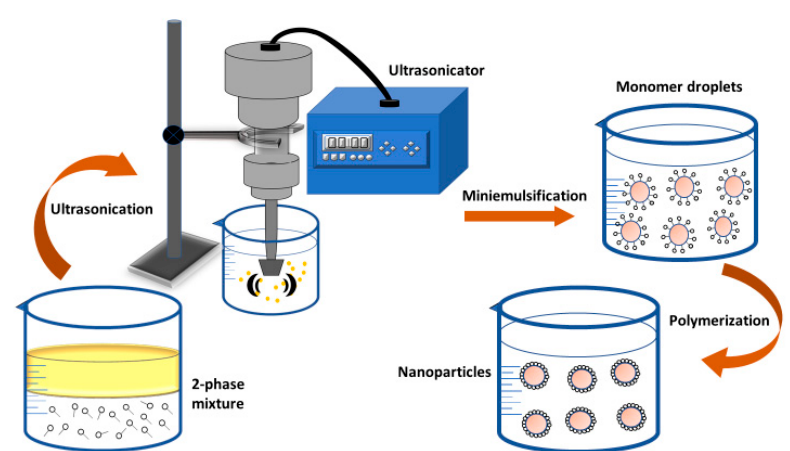
Figure 7. Diagram depiction of the mini-emulsion polymerization method.